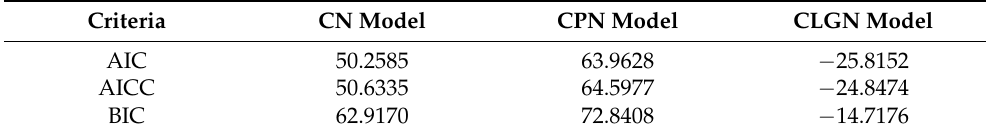
Table 7. AI and AICC for CN, CPN and CLGN linear